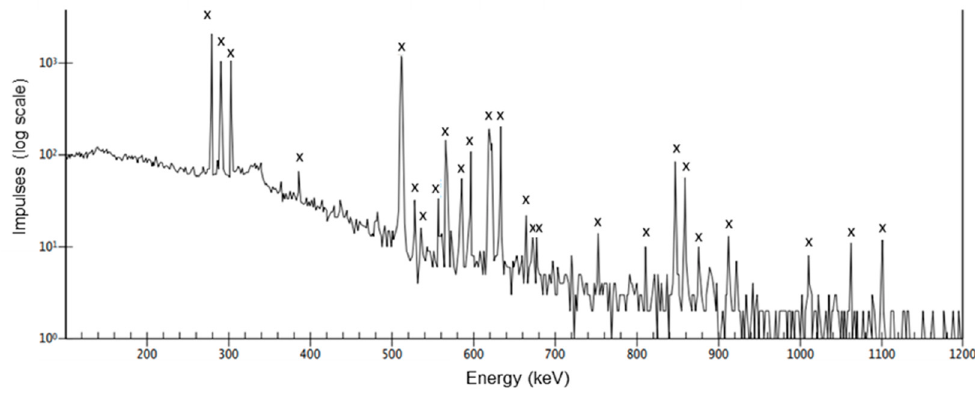
Figure 2. Representative gamma spectrum of the raw target solution 25 min after EOB. X—characteristic gamma lines for 133 La.